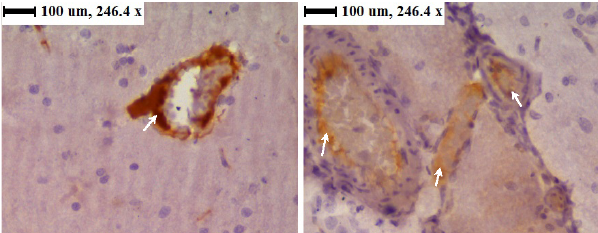
Fig. 5. Western blots showing the expression of tight junction proteins (occludin and claudin-5) in the brain of newborn and adult rats.